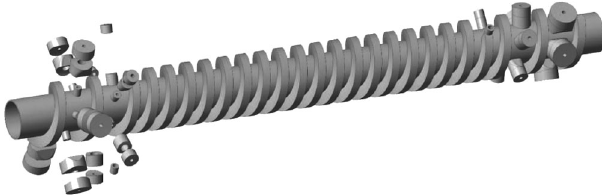
FIG. 9. The 1.2 m long HSCU mandrel during the machining process showing one of three support